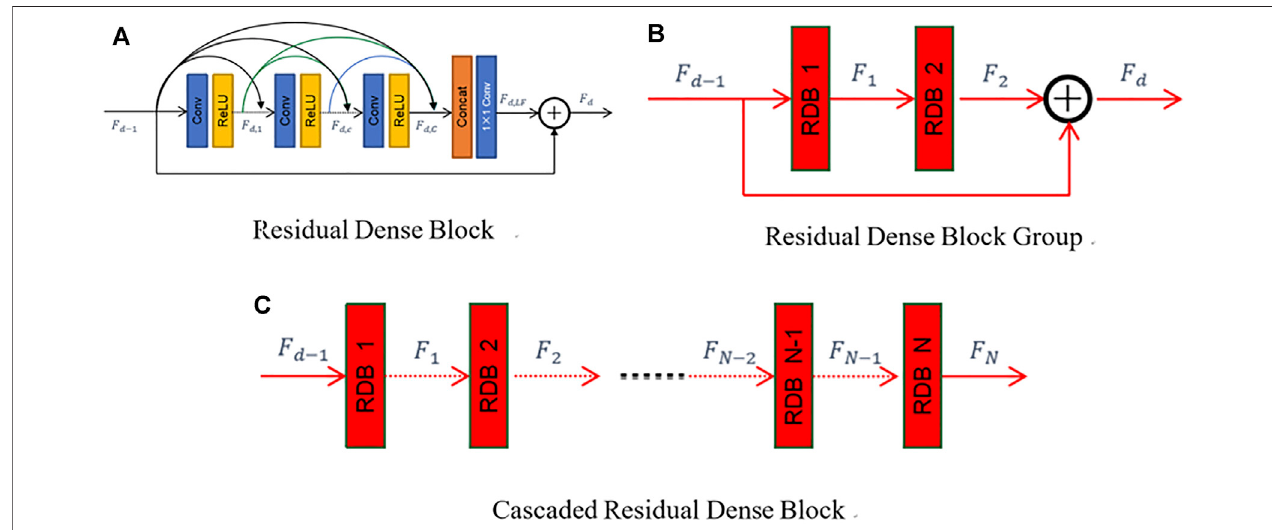
FIGURE3| Comparison ofRDB, CRDB,and RDBG. (A) RDB: itisamodulewithdenseconnectionsintheblock. (B) RDBG (proposed method): itiscomposedof two RDBs. RDBG forms the LRD between blocks. (C) CRDB: the RDB is cascaded to form a network.